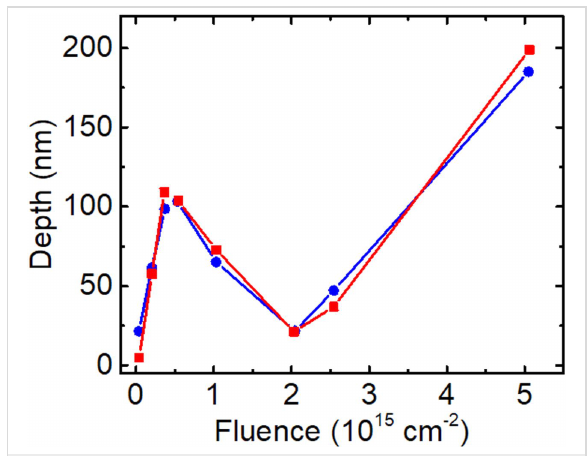
Figure 8: Fluence dependence of the irradiation-induced depth for a 15 nm Pt 60 Pd 40 /PDMS sample irradiated with a 25 keV He + FIB within a fluence range from 3.7 × 10 13 to 5.0 × 10 15 cm − 2 . The depth is deter- mined as the maximum depth within each irradiated area. Red squares and blue circles correspond to measurements performed in the irradi- ated areas of Figure 7a and Figure 7b, respectively.